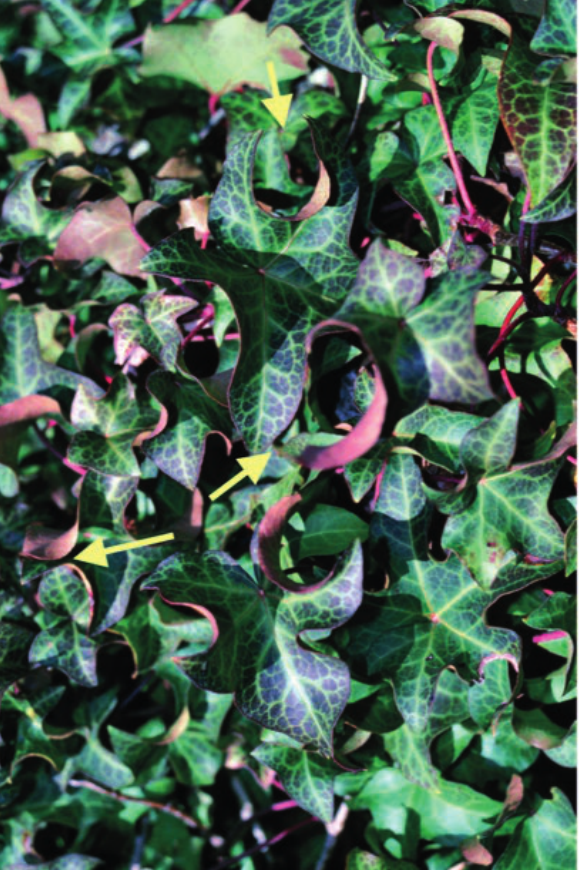
Figure 25. Some nearly-homogeneous hyperbolic leaves (arrowed) in an ivy. Notice the crowding of growing leaves, particularly evi- dent in the arrowed